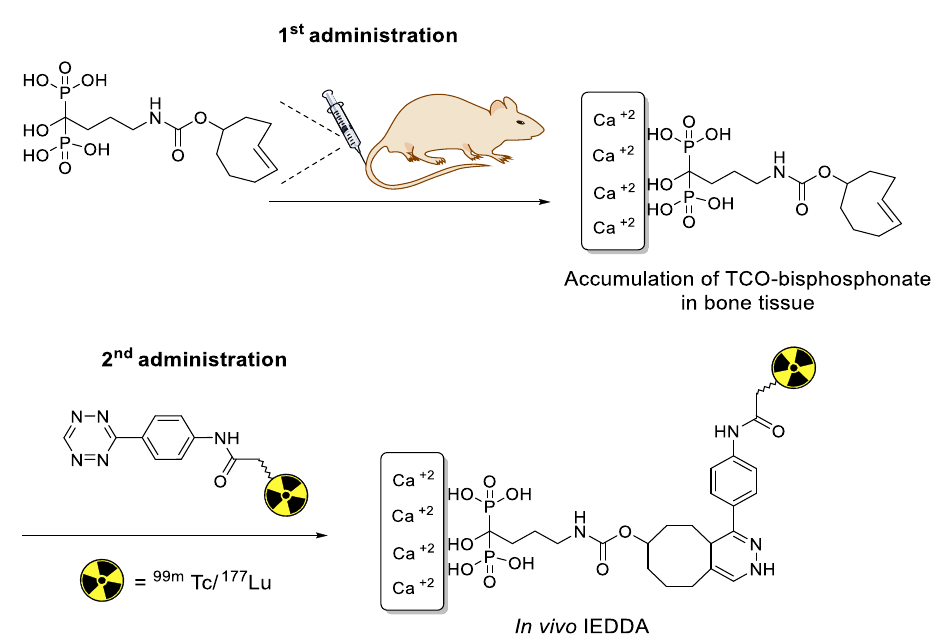
Figure 18. Pre-targeted IEDDA ligation between TCO-bisphosphonate and radiolabeled tetrazine in bone tissue.